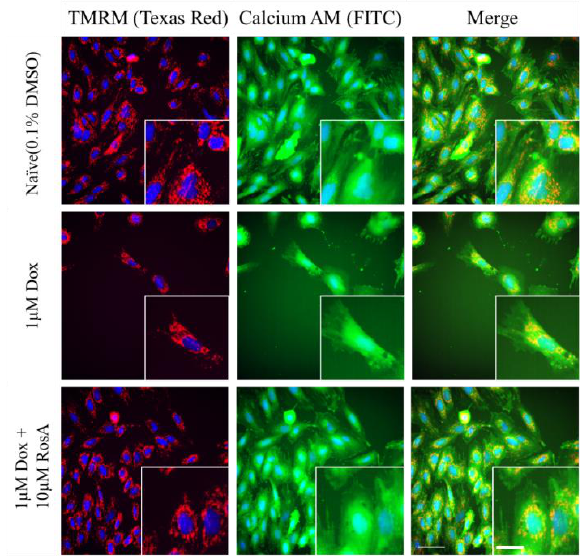
Figure 4. Phenotypes associated with model cells pretreated with RosA. The green fluorescence in the FITC channel is Calcein-AM, the red fluorescence in the Texas red channel is TMRM, and the blue fluorescence in the DAPI channel is Hoechst 33342.